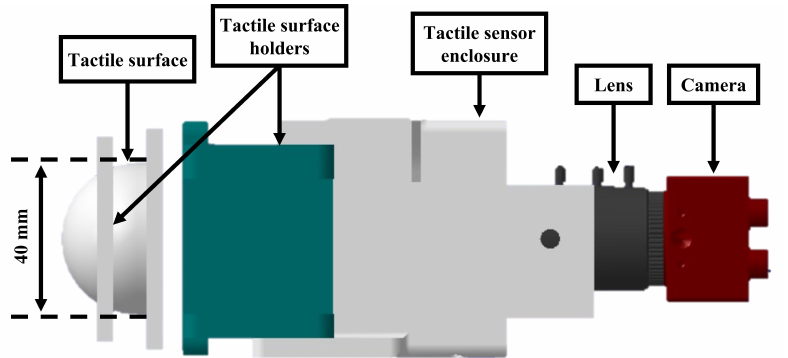
Figure 5. The sensor compact design consists of a 3D-printed enclosure that holds a camera facing the backside of the tactile surface to capture the markers’ arrangement.